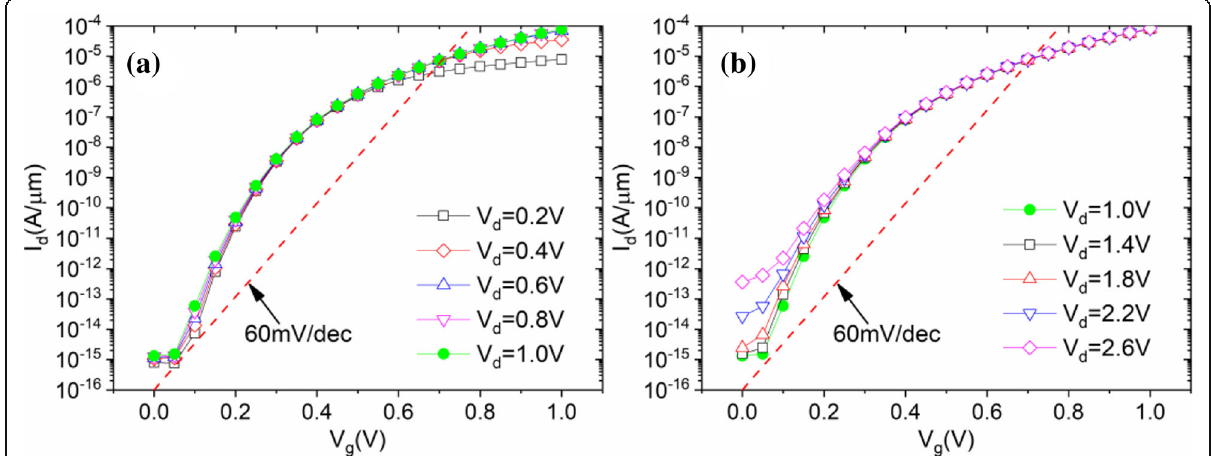
Fig. 9 Simulated drain currents for a V d ≤ 1 V and b V d ≥ 1 V